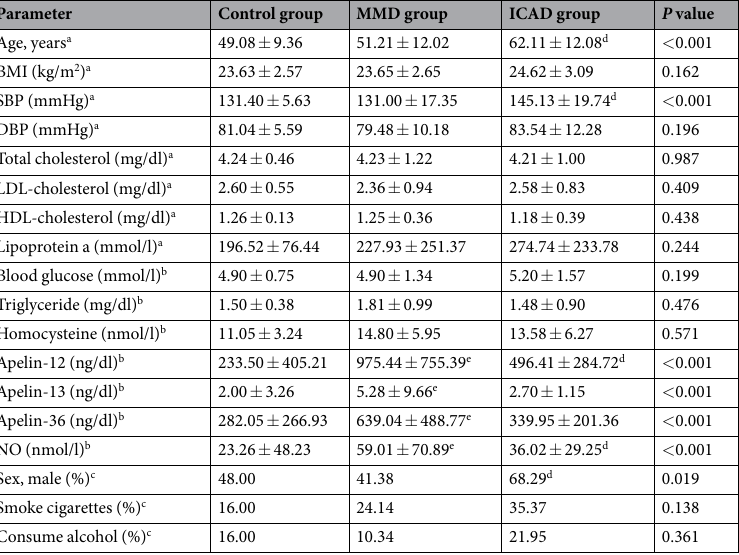
Table 1. Univariate analysis for Control, MMD, and ICAD groups. a Data are presented as mean ± SD; b Data are presented as median ± IQR; c Data are presented as %. BMI, body mass index; SBP, systolic blood pressure; DBP, diastolic blood pressure; NO, Nitric oxide; MMD, moyamoya disease; ICAD, intracranial atherosclerotic disease. d Significant difference vs. Control group and MMD group ( P < 0.017). e Significant difference vs. Control group and ICAD group ( P <